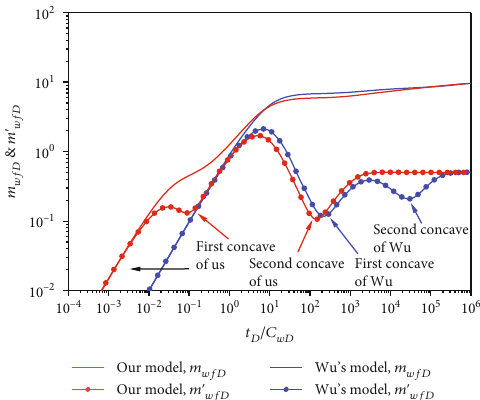
Figure 6: Typical curves of pseudopressure and pseudopressure derivative.